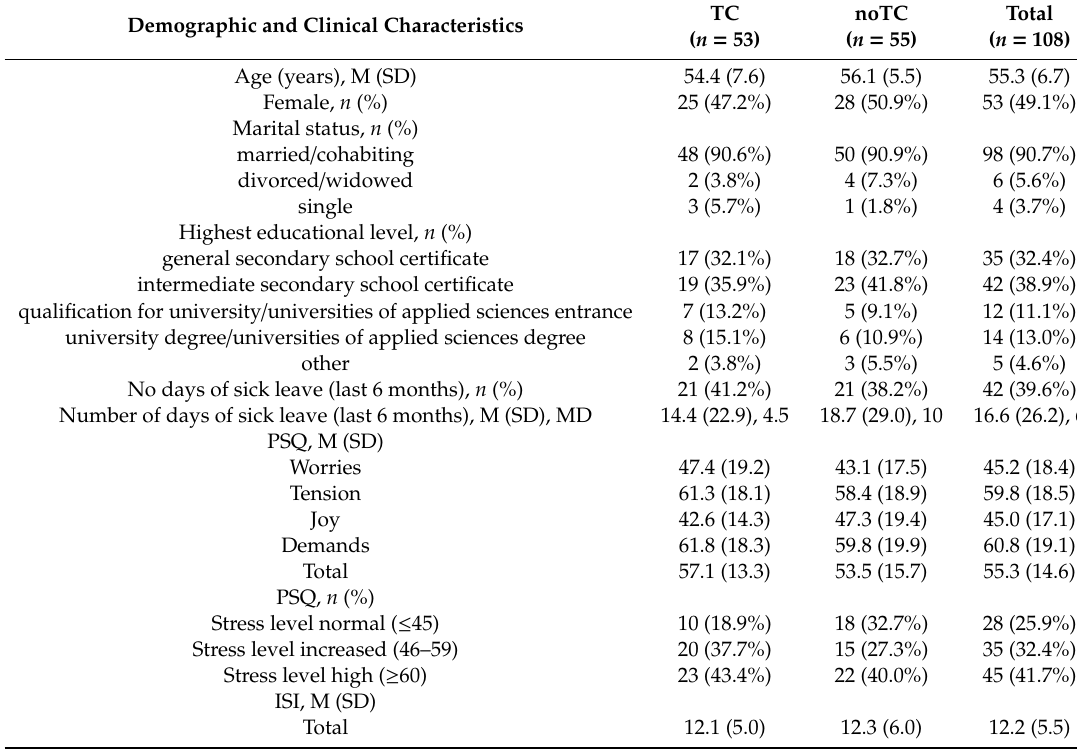
Table 2. Baseline demographic and clinical